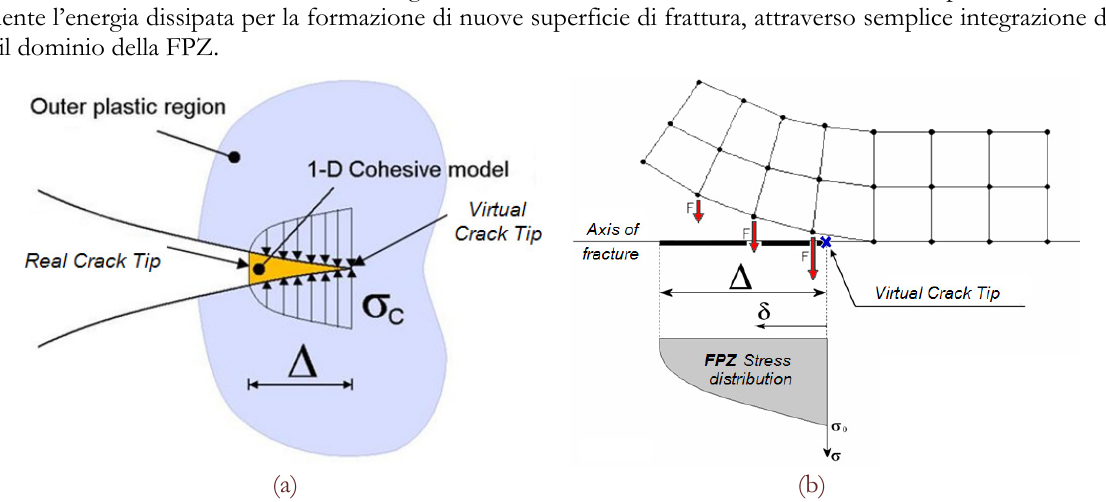
Figura 5: Schema del modello coesivo monodimensionale (a) e distribuzione delle forze nodali (b)